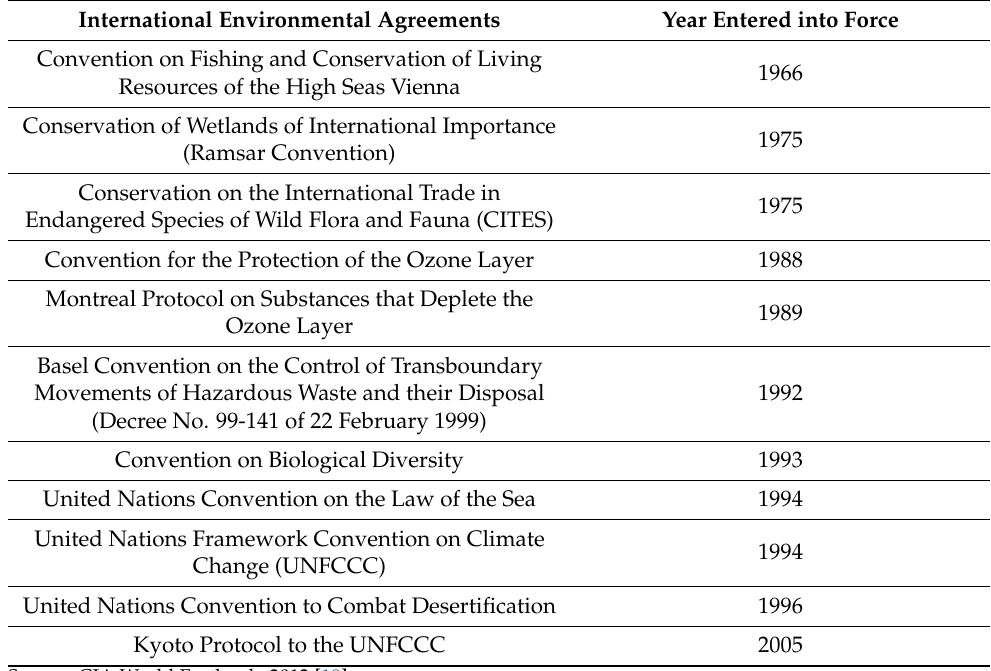
Table 3. Madagascar’s International Environmental